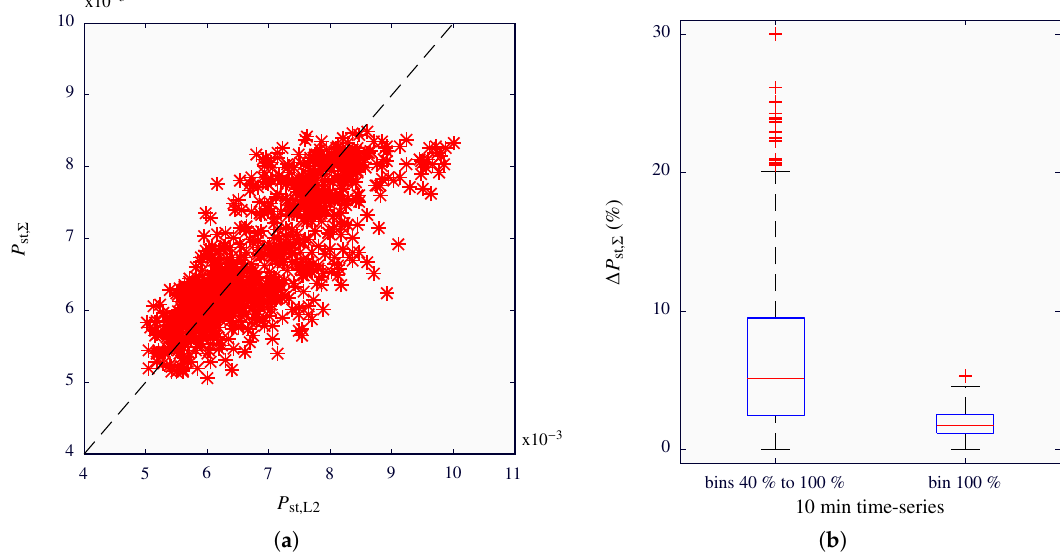
Figure 10. Deviation between the estimated P st, Σ and measured P st,L2 values at the PCC, for α = 3. ( a ) Estimated versus measured results, obtained with the time series classified between the power bins 40% to 100%. ( b ) Boxplots of the percentage deviation between the estimated P st, Σ and the measured P st,L2